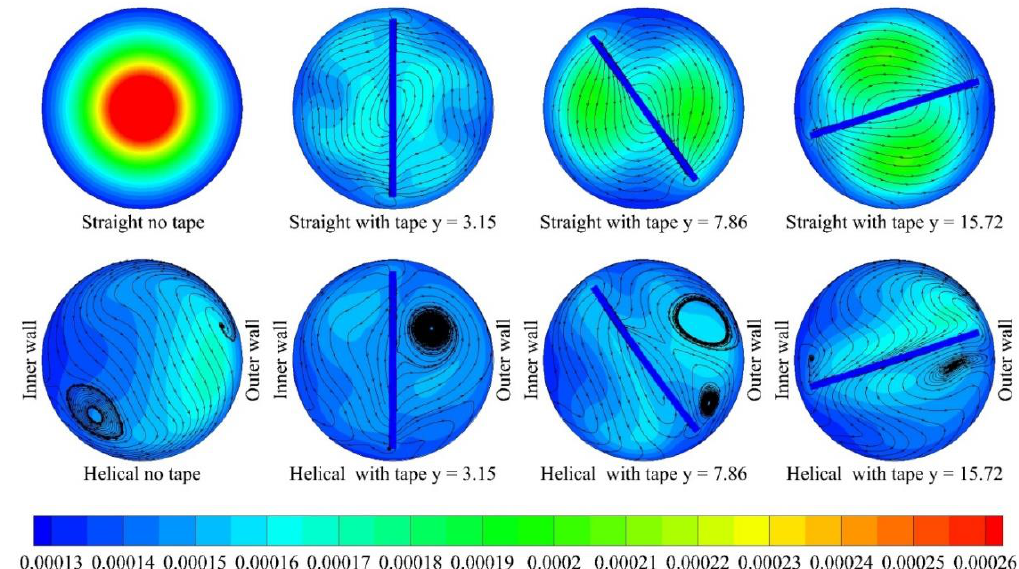
Figure 3. Methane concentration (kmol / m 3 ) and masslines of reactant flow in straight and helical reactors with various twisted tape insert configurations at L = 25.16 mm and Reynolds number of 1000.